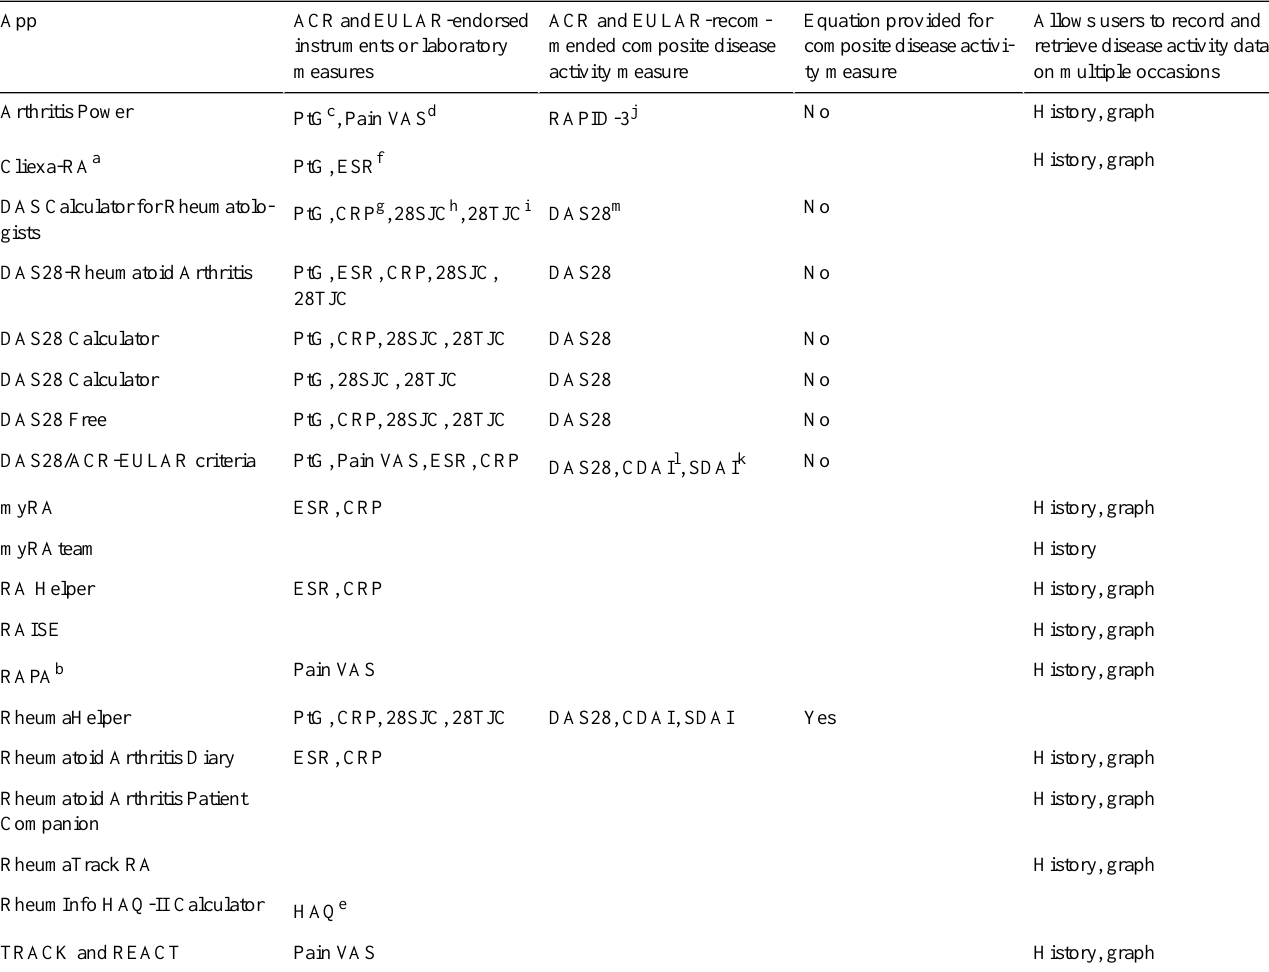
Table 5. App inclusion of the rheumatoid arthritis (RA) activity measures and component measurement instruments.